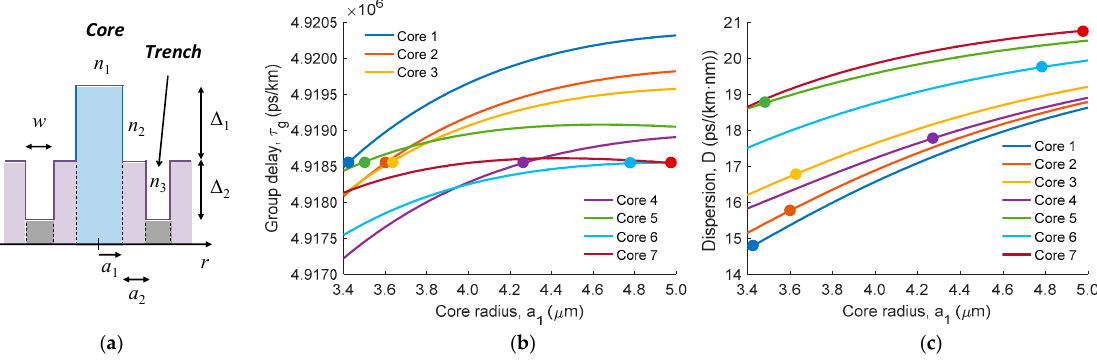
Figure 2. ( a ) Refractive index profile of the fiber cores; ( b ) group delay; and ( c ) chromatic dispersion of each core as a function of the core radius. Each filled circle represents the selected core radius and the corresponding group delay and chromatic dispersion values.